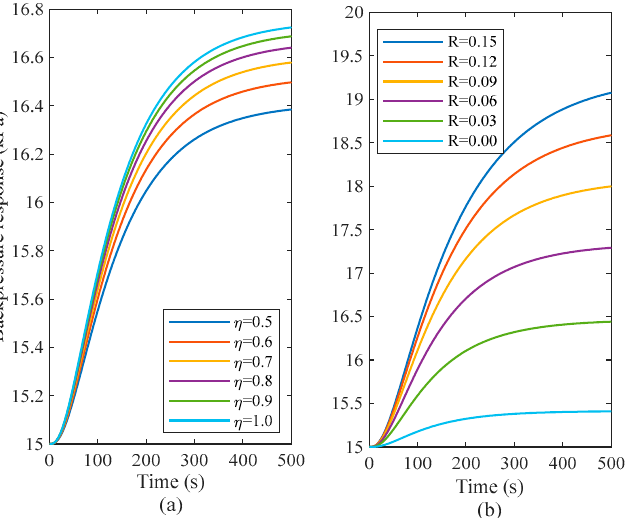
Figure 5. Response of backpressure to fan speed step test: ( a ) backpressure at different fan volumetric effectiveness; ( b ) backpressure at different plume recirculation rates.